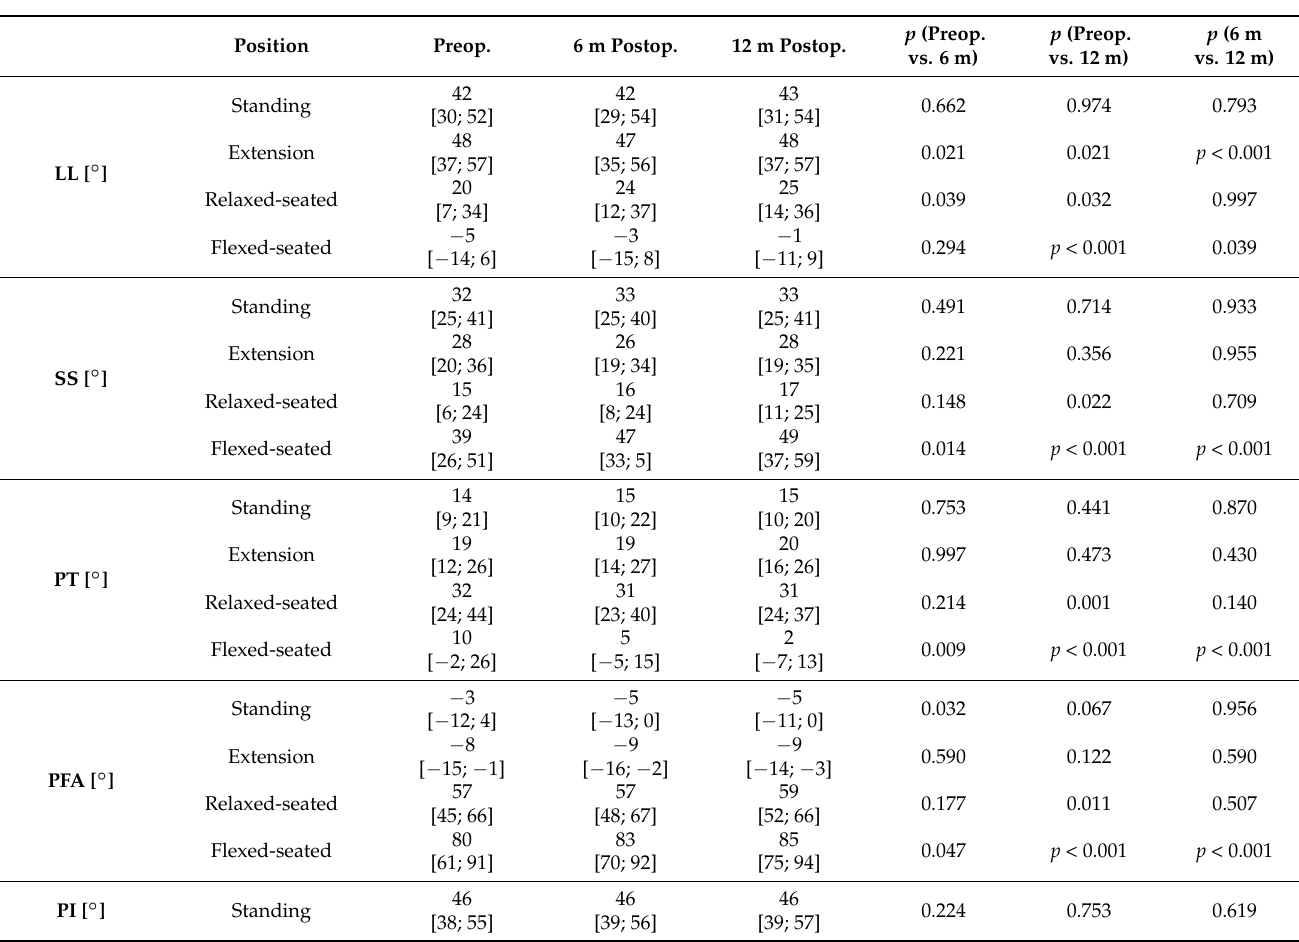
Table 2. Spinopelvic parameters of the patients in standing, extension, relaxed-seated, and flexed- seated positions preoperatively (preop.) and 6 months (6 m) and 12 months (12 m) postoperatively (postop.). Values are reported as median [quartiles], and p -values are reported for significant differ- ences between preoperatively and postoperatively. Parameters are: L1-S1 lumbar lordosis (LL), sacral slope (SS), pelvic tilt (PT), pelvic-femur angle (PFA), pelvic incidence (PI), pelvic incidence minus lumbar lordosis (PI-LL), and